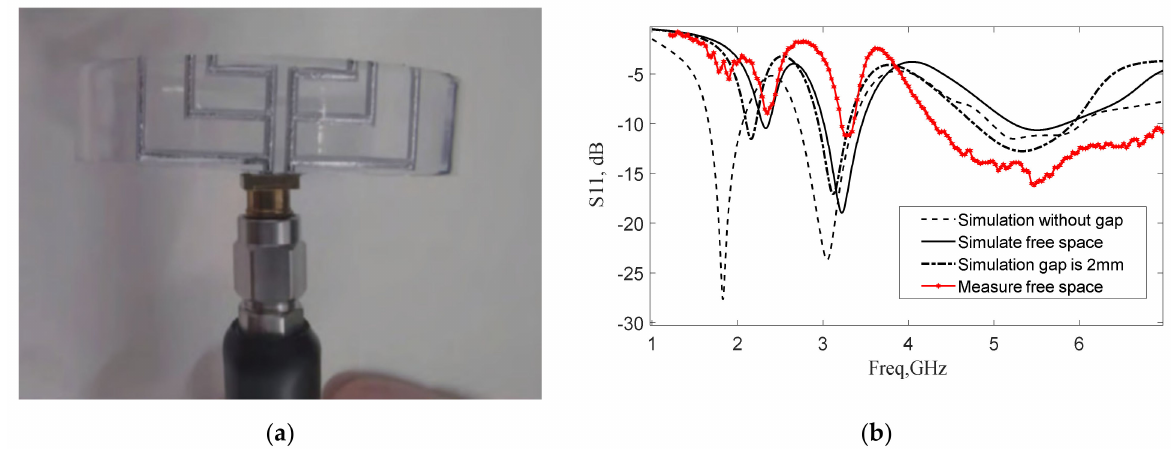
Figure 20. ( a ) 3-D printed tri-band LM antenna. ( b ) Reflection coefficients of the tri-band bracelet antenna. Reprinted from Ref.